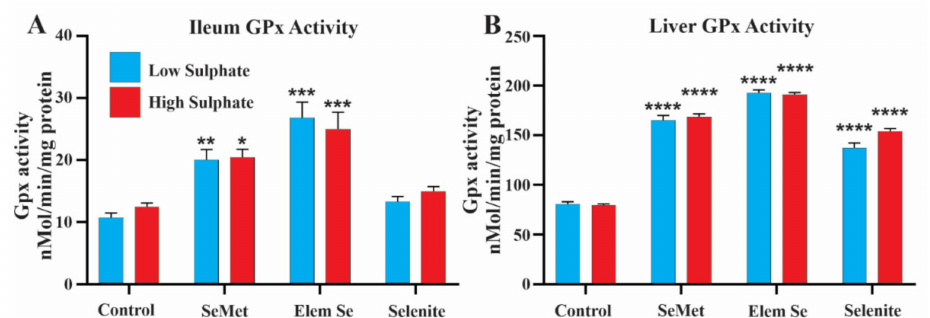
Figure 4. Comparison of GPx activity in low sulphate and high sulphate diets. ( A , B ): GPx activity in ileum and liver tissue of mice fed low or high sulphate l-selenomethionine (SeMet), nanoelemental Se or sodium selenite diets at 0.3 parts per million (ppm) for 5 weeks, respectively. One-way ANOVA was carried out with Tukey’s multiple comparisons between groups. Data is presented as mean ± SEM. p < 0.05 *, p < 0.01 **, p < 0.001 ***, p < 0.0001 ****. Low or high sulphate diets were compared between Se supplemented and control diets, i.e., low sulphate control compared with low sulphate